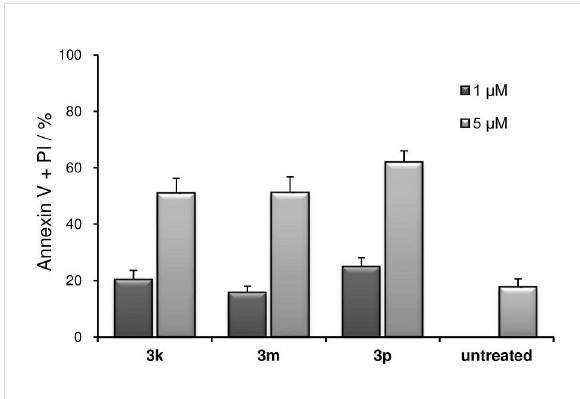
Figure 5: 3k , 3m and 3p induced cell death in AGLCL, a human normal B cell line. Briefly, AGLCL cells (1 × 10 4 cells/mL) were incu- bated with each test compound at 1 μ M and 5 μ M for 24 h. Cells were stained with annexin V and propidium iodide (PI). The data shown is the mean ± SD ( n =